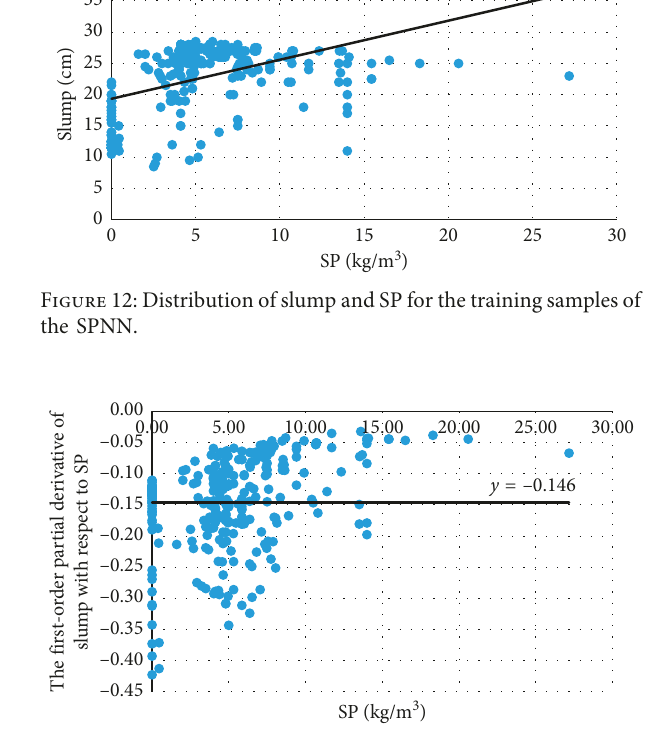
Figure 13: Distribution of SP and the first-order partial derivative of slump with respect to SP for the training samples of the